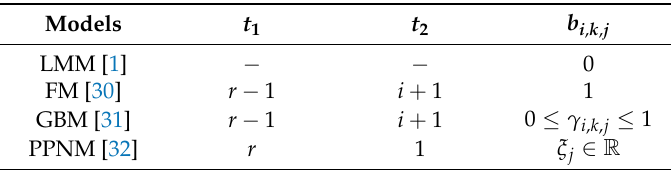
Table 1. Parameters of different mixture